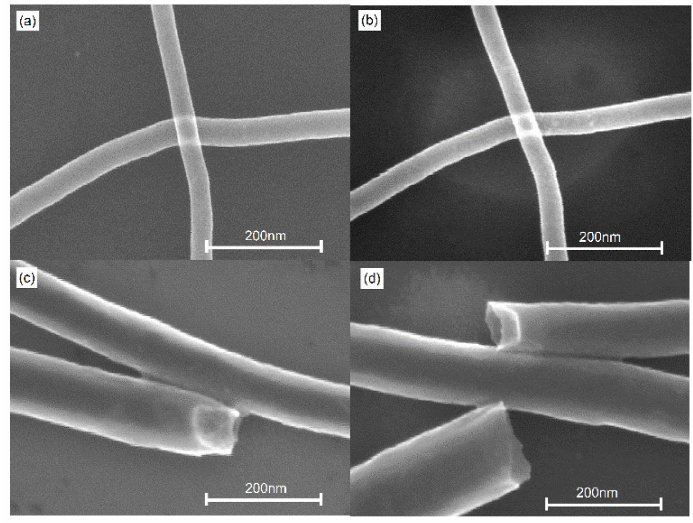
Figure 3. SEM images of ( a ) raw MWCNT samples and ( b ) crossed MWCNTs after 10 s laser irradiation, ( c , d ) parallel MWCNTs after 10 s laser